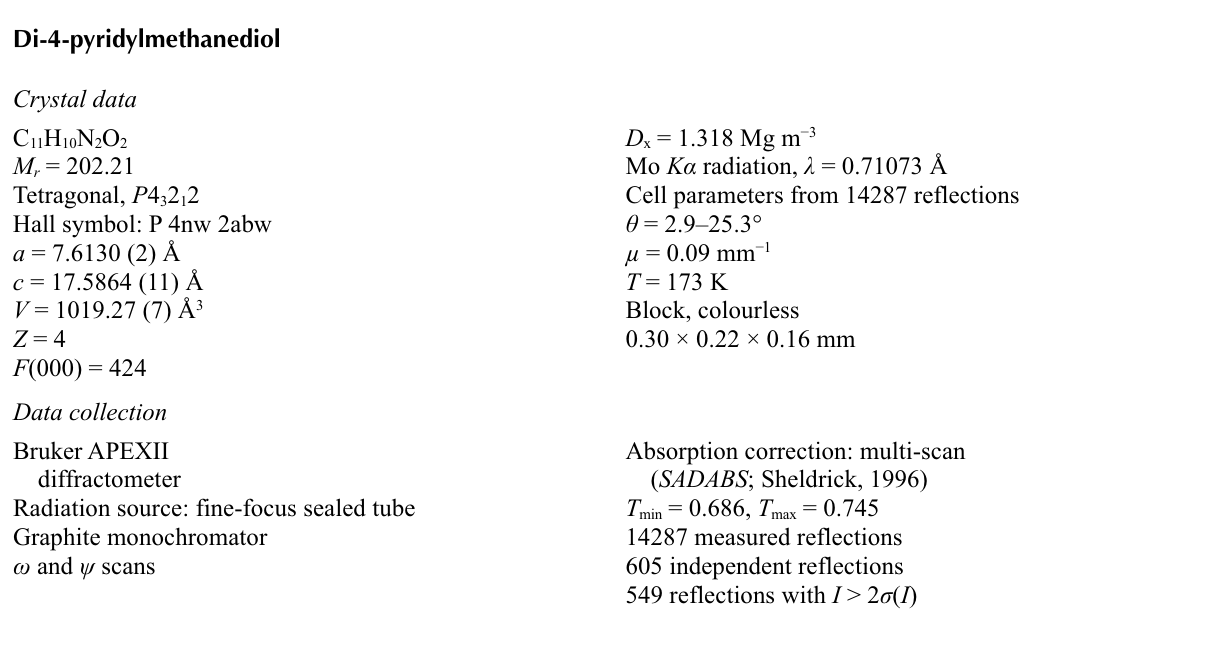
A view down c of the offset double layer motif in the title